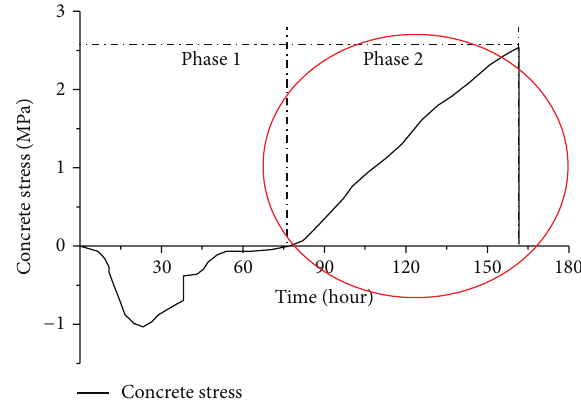
Figure 11: A typical stress